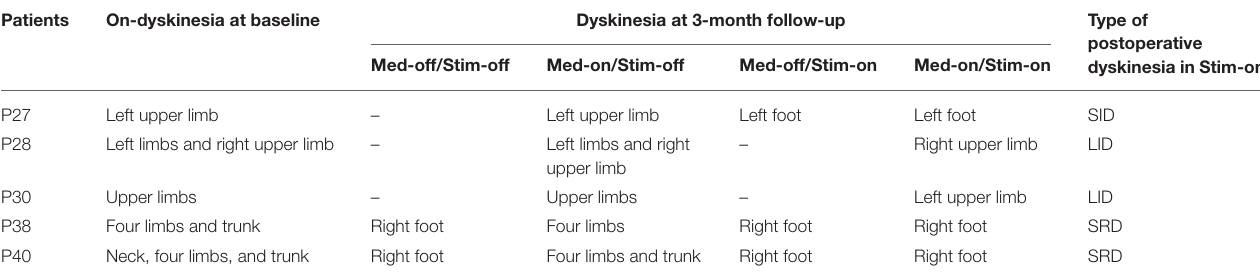
TABLE 1 | Body parts involved by dyskinesia.